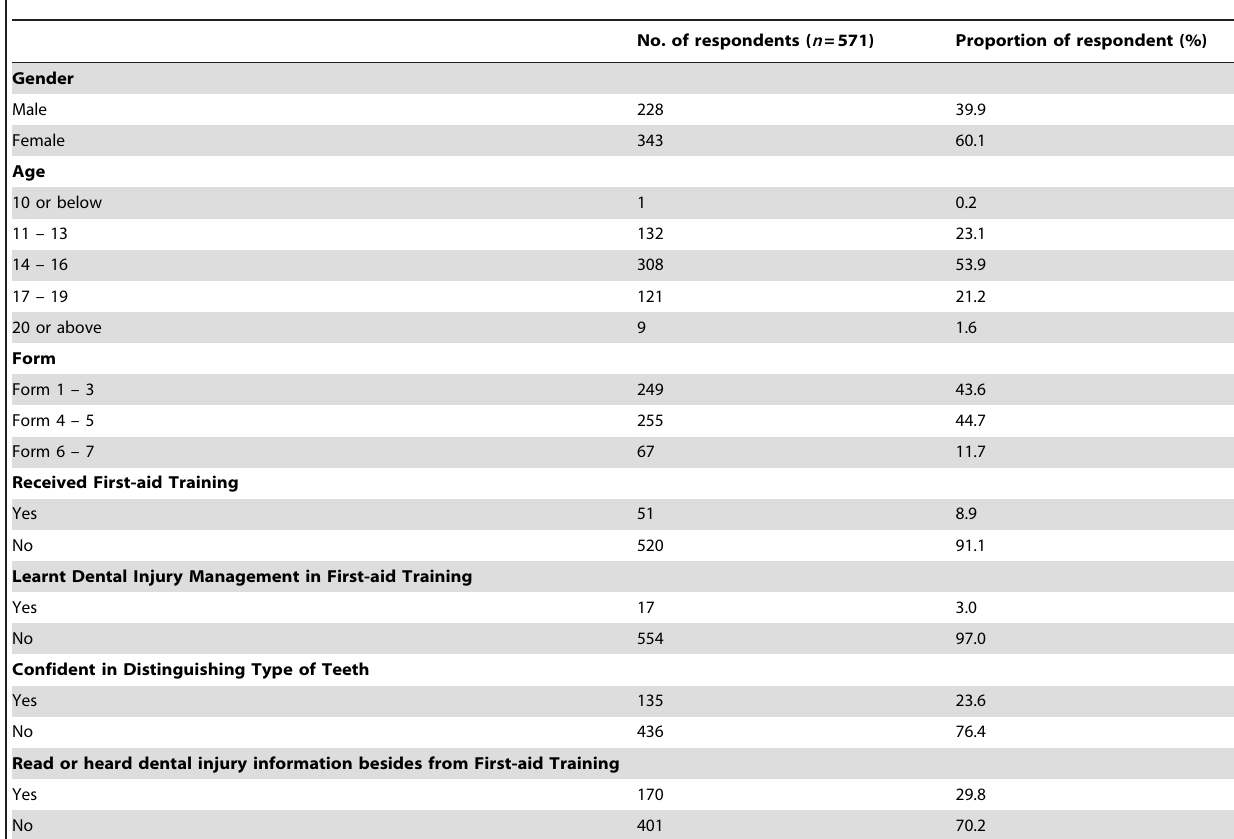
Table 2. Part 1 Demographics and characteristics of